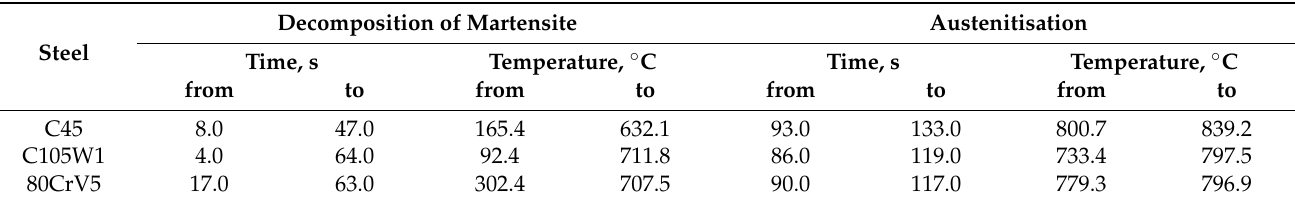
Table 2. Phase transformations of the samples.